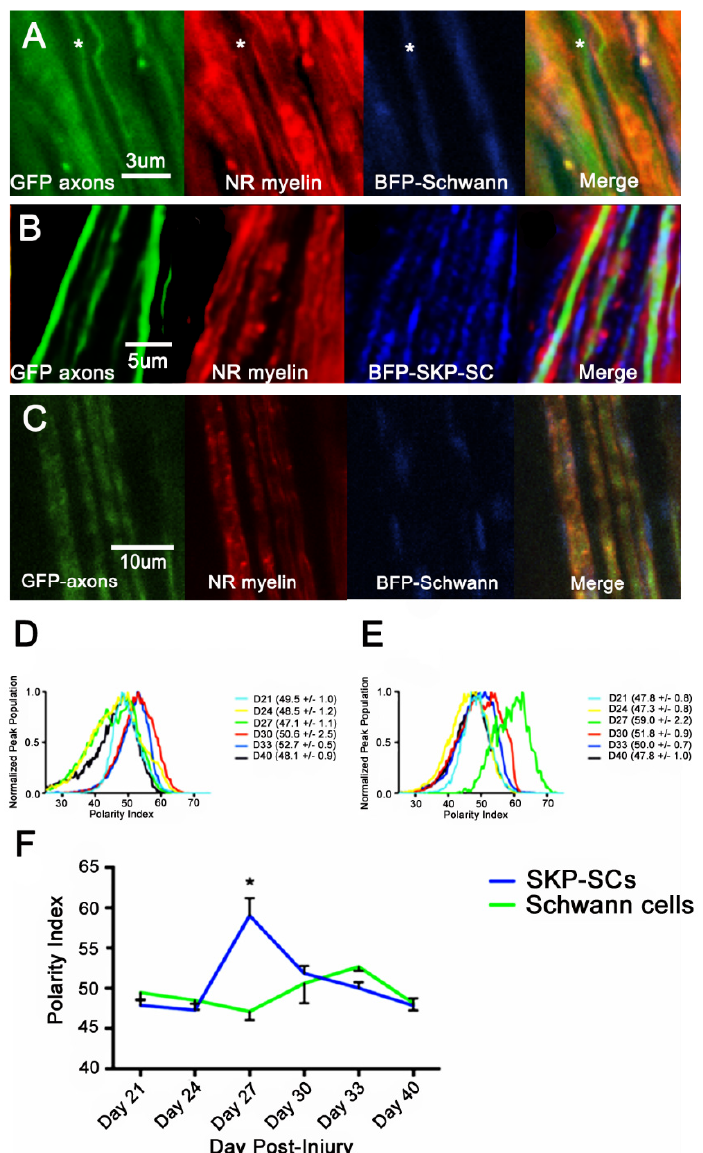
Figure 5. Intravital polarity index analysis of SKP-SCs and Schwann cell transplants over sequential days of myelination. (A – C ) High magnification intravital images of BFP + ve SKP-SC and Schwann cell myelination, demonstrated as three-channel images. Green = GFP + axons, Red = Nile Red stained myelin, Blue = BFP + ve cytoplasm and nucleoplasm of injected cells. ( A ) 21 days post-doxorubicin injury, 11 days post BFP-Schwann cell injection. * = Thinly myelinated axon ( B ) 27 days post-doxorubicin injury, 19 days post BFP-SKP-SC injection. ( C ) 40 days post doxorubicin injury, 31 days post BFP-Schwann cell injection. ( D ) BFP-Schwann cell myelin PI average distributions ( E ) BFP-SKP-SC myelin PI average curves. F) Peak Polarity Index values vs. time, Schwann cells (green line) and SKP-SC cells (blue line). SKP-SC day 27 myelin is red shifted compared to Day 27 SC myelin (Two-way ANOVA, α = 0.05, Tukey’s post-hoc test). Both data demonstrate a significantly changing biphasic polarity index with time, moving from an early blue shifted Polarity Index, through a red shifted Polarity Index, and back to a blue shifted Polarity Index at the most mature time points.